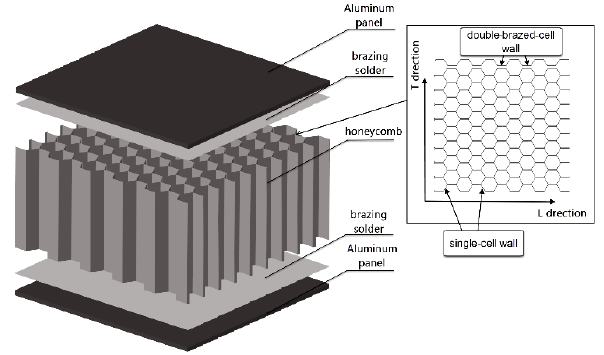
Figure 1. Model of a brazed aluminum honeycomb plate (BAHP).